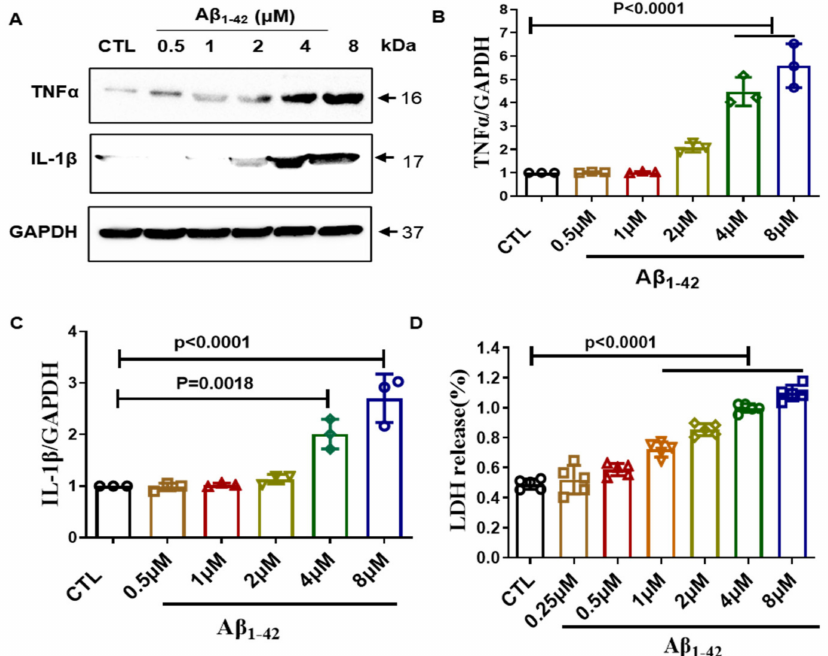
Figure 1. Establishment of cell inflammation model in BV2 cells. ( A ) BV2 cells were treated with different doses of A β 1–42 (0.125–8 µ M), and the expression of TNF- α and IL-1 β were detected by using Western blot. ( B , C ) Quantification of TNF- α and IL-1 β results in A. ( D ) BV2 cells were treated with different doses of A β 1–42 (0.125–8 µ M), and the cell membrane damage was measured by LDH assay. p < 0.05 was considered significantly